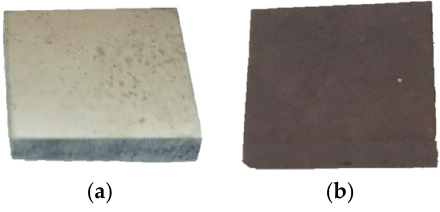
Figure 7. Photographs of a HC-2 sample ( a ) before and ( b ) after corrosion in 10 vol. % NaOH for 24 h.